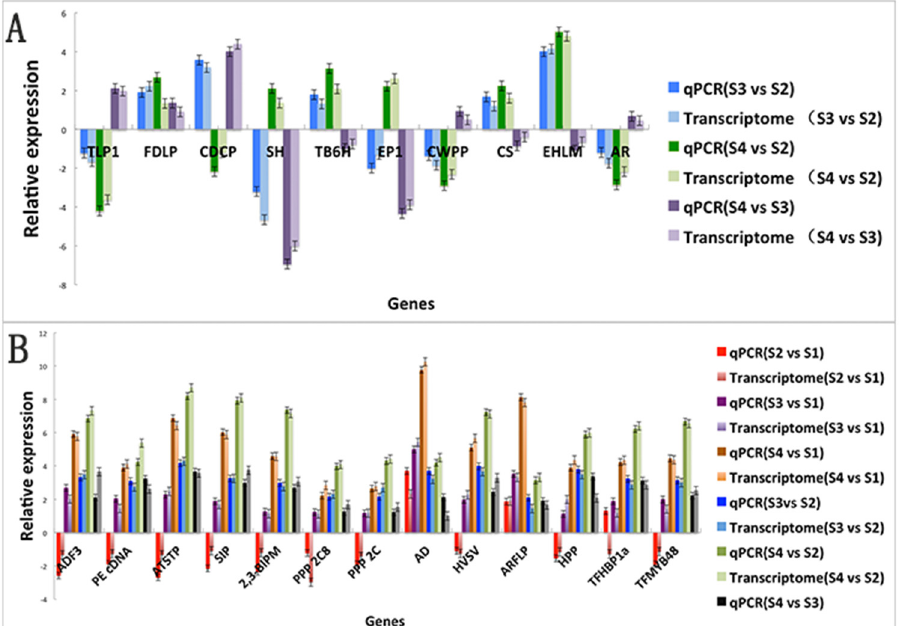
Figure 9. Fluorescence quantitative PCR results of differentially expressed genes in dual-seq. Note: ( A ) The 10 differentially expressed genes of A. phaeospermum under different infection periods were verified by fluorescence quantitative analysis; ( B ) The 13 differentially expressed genes of B. pervariabilis × D. grandis were verified by fluorescence quantitative analysis under different infection